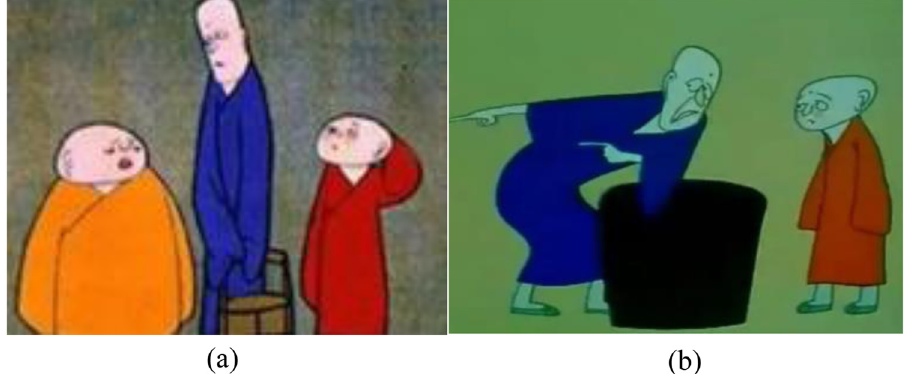
Figure 8: Character color settings in “ Three Monks. ” ( a ) Three monks; ( b ) two